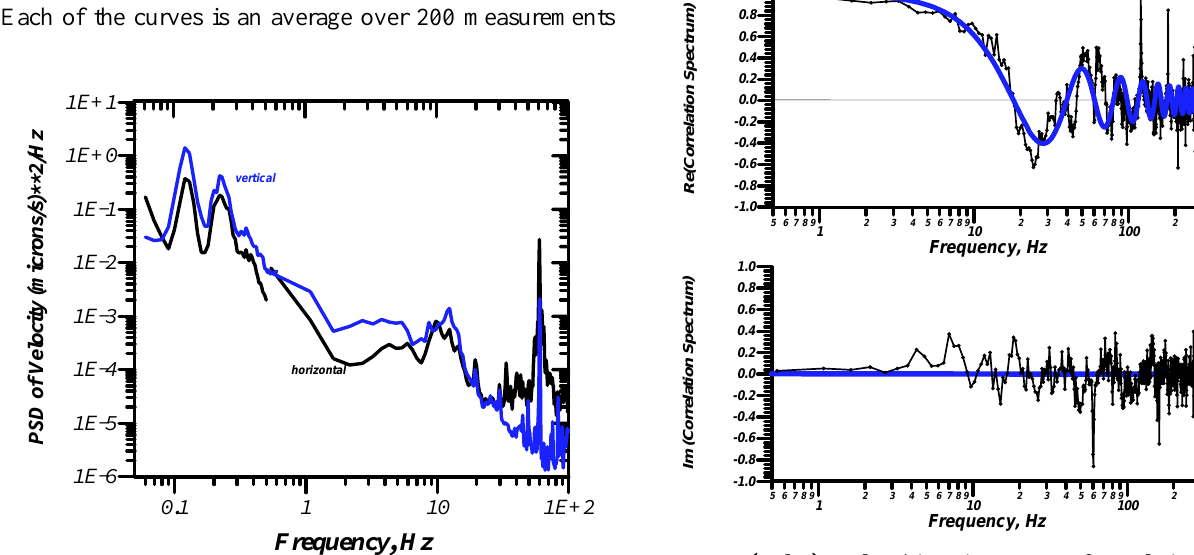
FIG. 16. (Color) Real and imaginary parts of correlation spectra measured in the TARP shaft at a distance of 75 m between probes and fit accordingly to the random source